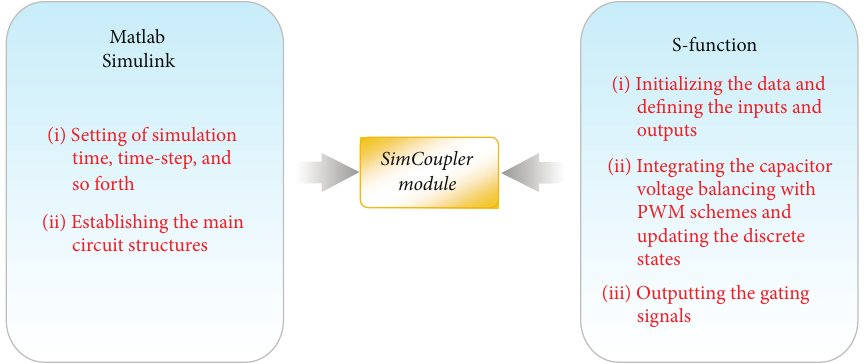
Figure 5: Matlab/Simulink and S-function